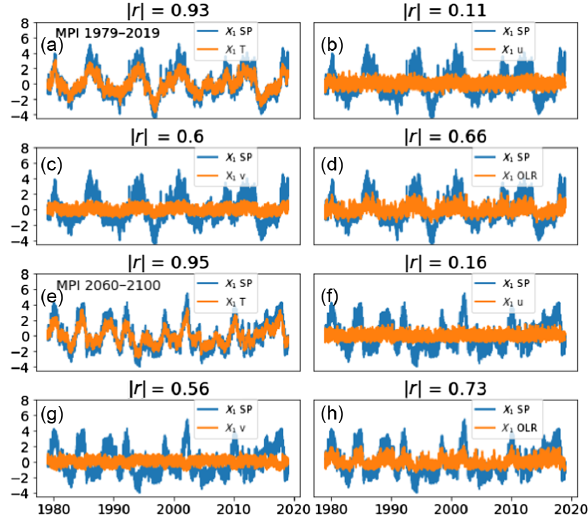
FIG. 18. First Isomap ( X 1 ) component for anomalies in periods 1979 – 2019 and 2060 – 2100 in the MPI model in panels (a – d) and (e – h) respectively. In each case components have been standard- ized so that the total variance is equal to 1. Projections in the multivariate case are shown in blue and labeled as “ SP ” (state space). Projections for each univariate field are shown in red. Atop of each plot we report the correlation coefficient (in absolute value) between the projections in the multivariate and univariate